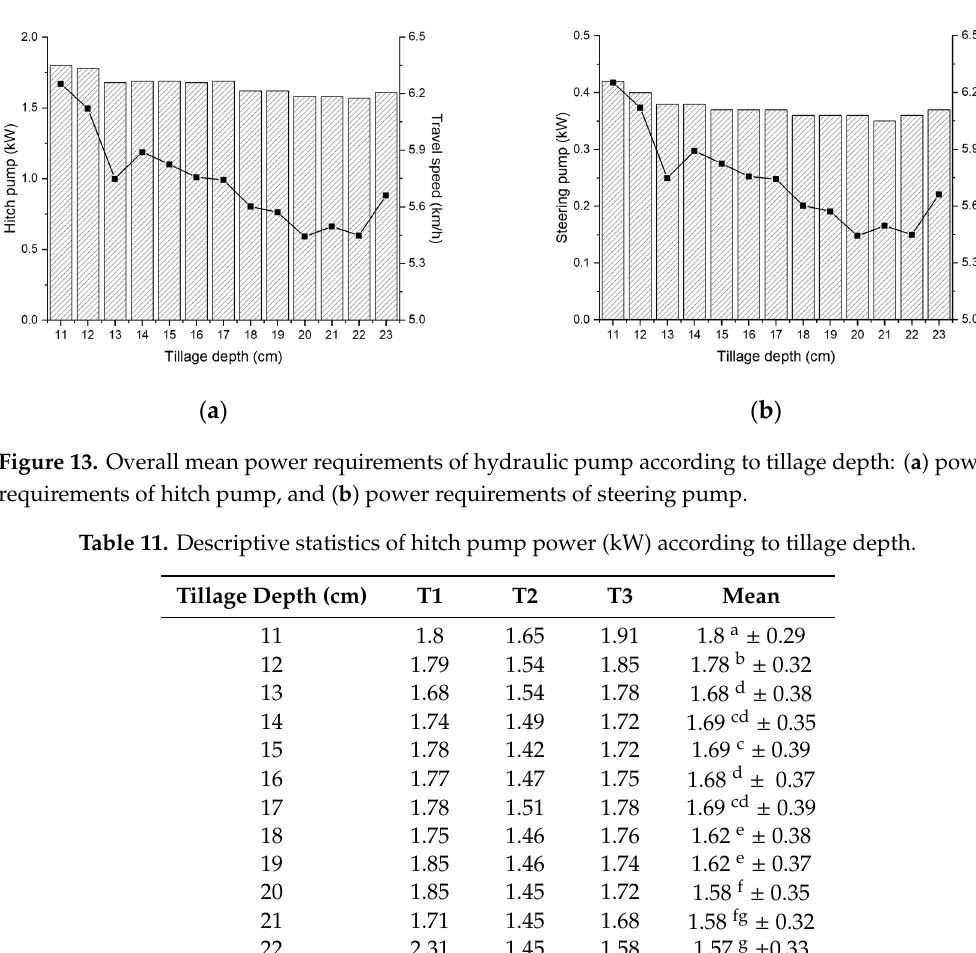
different at p < 0.05 according to Duncan’s multiple range tests.